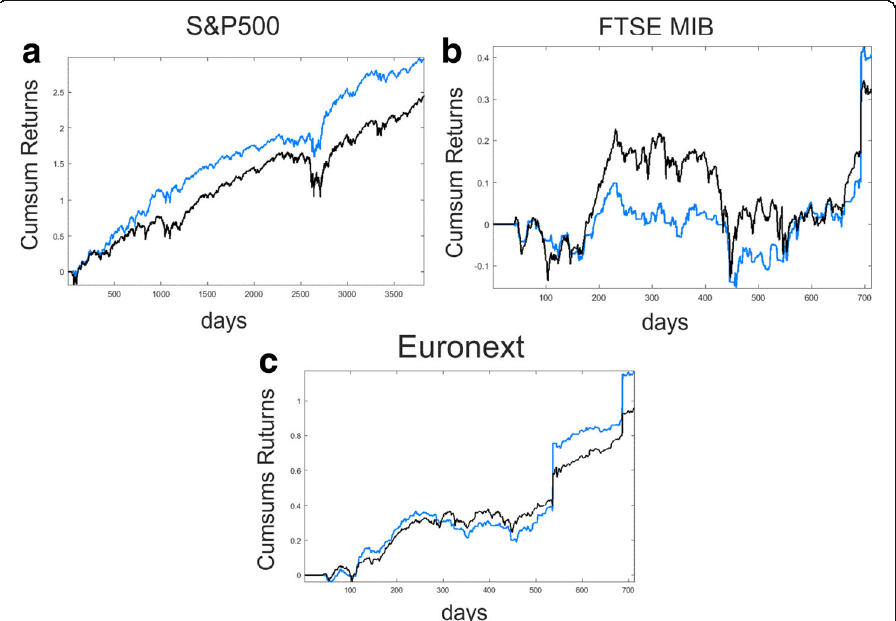
Fig. 3 Cumulative sum of returns obtained with the signal-optimized portfolio strategies ( blue lines ) together with the cumulative performance of the equal weight investment strategy ( black lines ). Figure 3 a shows the performance of the investment strategy for the basket of stocks belonging to the S&P500. Panel b reports the results for the basket of stocks belonging to the FTSE MIB and panel c presents the cumulative sum of returns for the basket of stocks belonging to the Euronext Paris stock